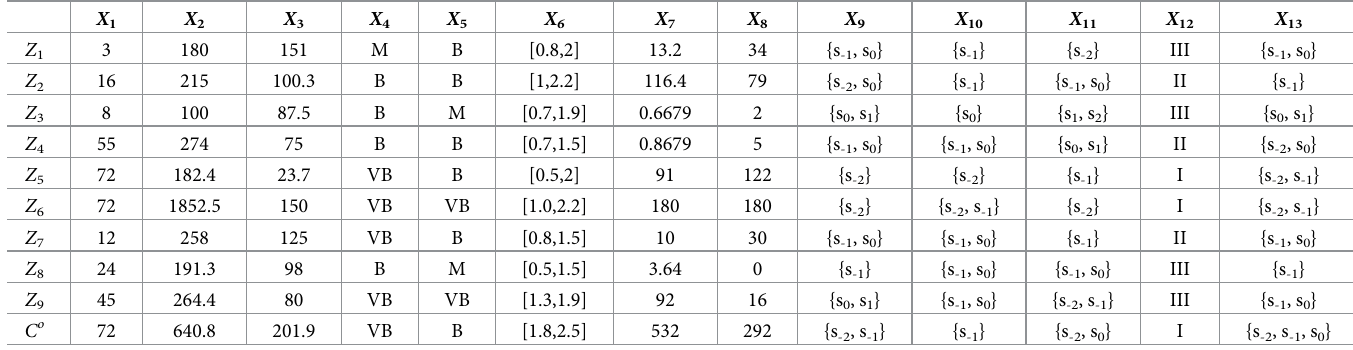
Table 2. Initial decision matrix.